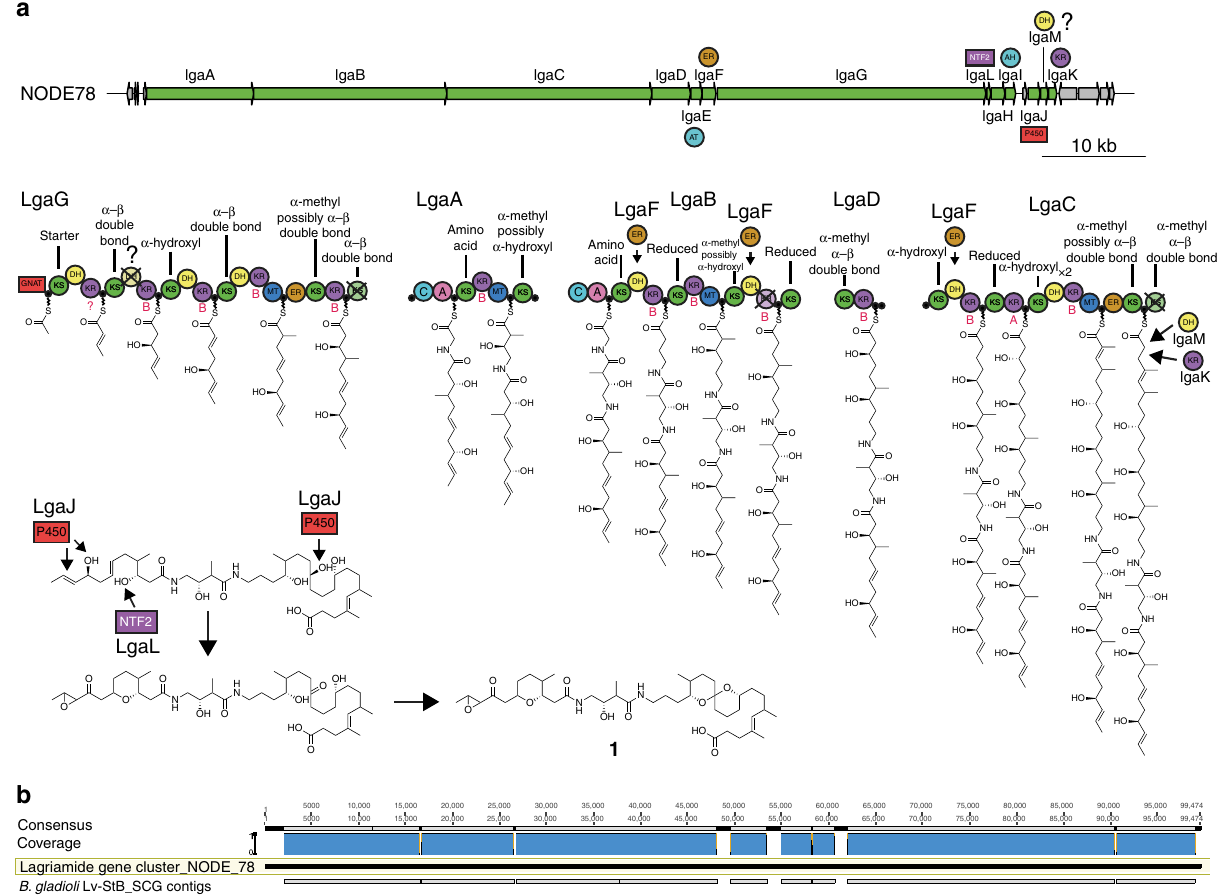
Fig. 4 A putative gene cluster for lagriamide biosynthesis is present in the genome of the Burkholderia gladioli Lv-StB symbionts of Lagria villosa . a Annotation of the lgaA-lgaM hybrid PKS-NRPS gene cluster and predicted biosynthesis of lagriamide. The trans -AT PKS/NRPS pathway consists of 17 modules. The formation of the epoxide, tetrahydropyran, and spiroacetal moieties is proposed to occur after release from the terminal PKS. Filled black circles depict acyl carrier protein (ACP) domains; a cross indicates domains predicted to be catalytically inactive. Predicted subtype (A or B) is shown adjacent to KR domains in red, and the predicted substrate speci fi city of KS domains is shown above the respective domain. A: adenylation domain, AT: acyltransferase, AH: acylhydrolase, C: condensation domain, DH: dehydratase, ER: enoyl-reductase, KR: ketoreductase, KS: ketosynthase, MT: C -methyltransferase, NTF2: nuclear transport factor 2-like superfamily protein, P450: cytochrome P450. b Lagriamide biosynthesis gene cluster aligned to eight of the contigs obtained from single-cell genome sequencing of B. gladioli Lv-StB revealing 100% sequence